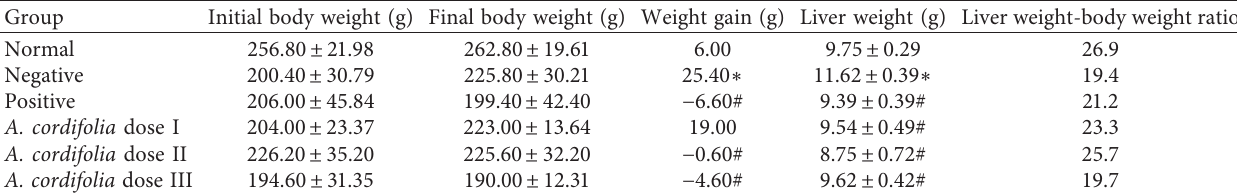
Table 2: Bodyweight and liver weight of rats.